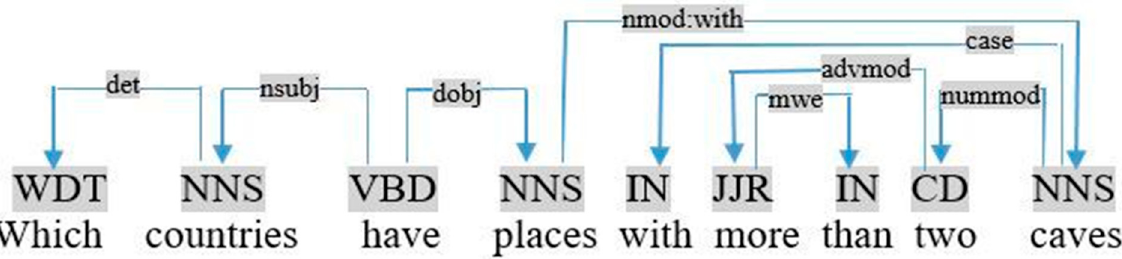
Figure 14. Graph dependency of the query «which countries have places with more than two caves».